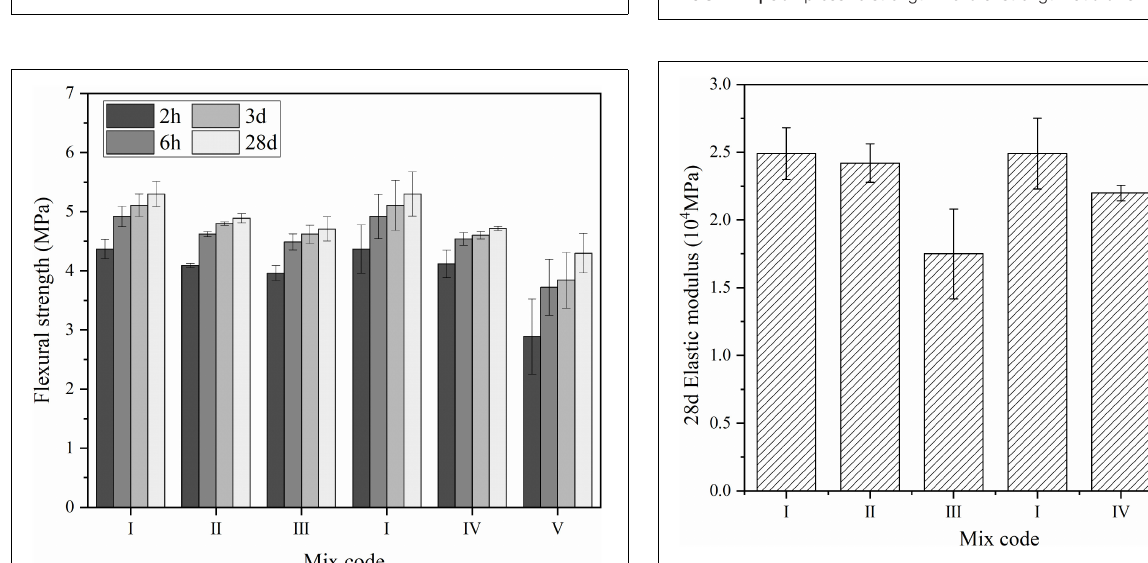
FIGURE 4 | Compressive strength -flexural strength ratio of CAEM.